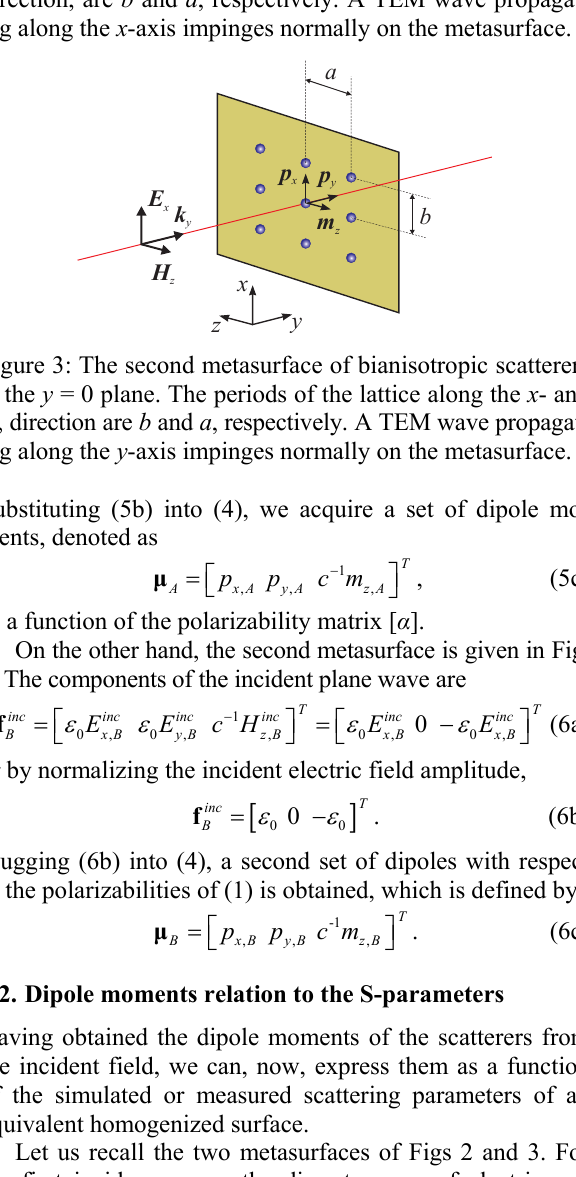
Figure 1: Geometry and axes definition of the EC-SRR. may be appropriately modeled by two electric dipole mo- , p and a magnetic dipole moment m ments p x y